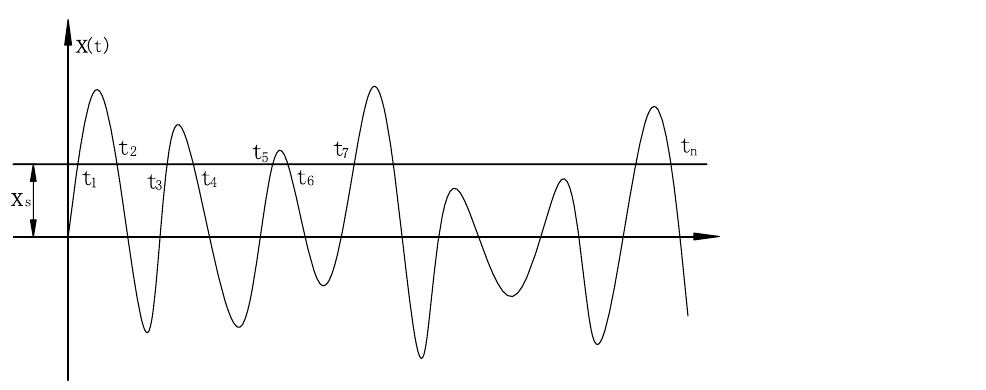
Figure 6. Cut out method for obtaining RDT